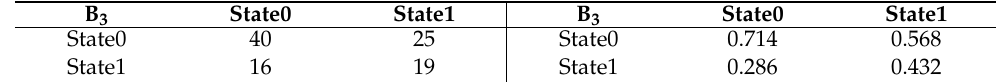
Table 5. 𝐶 1 frequency statistics and conditional probability table. Table 5. C 1 frequency statistics and conditional probability table.